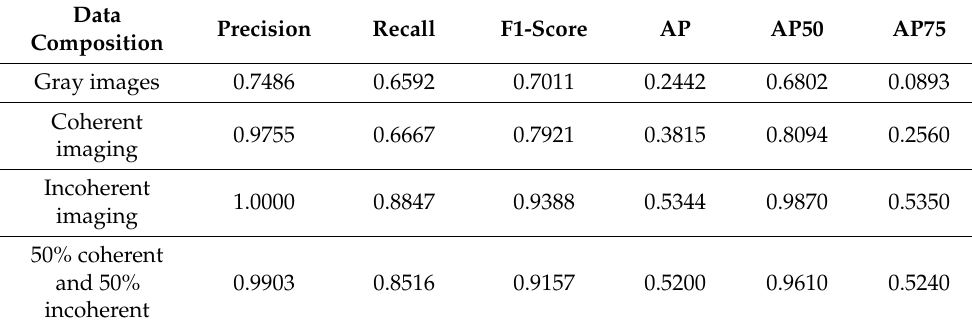
Table 3. The performance of the model on the test set with different training sets. Data